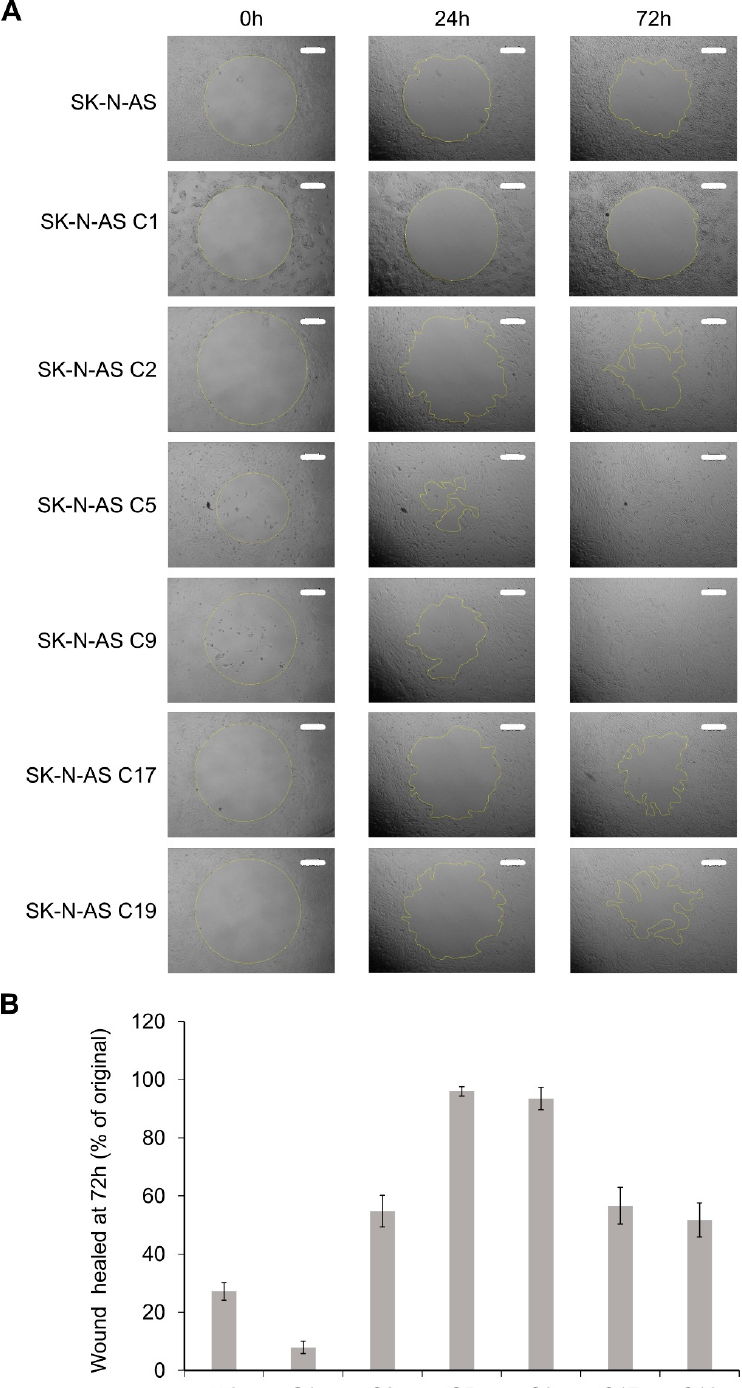
Figure 6. SK-N-AS RET KO cells display enhanced cell migration. ( A ) Phase-contrast microscopy images of indicated RET CRISPR/Cas9 engineered SK-N-AS cells at three time-points (0 h, 24 h, and 72 h) showing the migration difference with radius cell migration assay (scale bar = 300 μ m). Irregular lines indicate the front edge of cell migration, and the cell migrating areas were quantified in ( B ) with ImageJ 1.53a. Values represent the mean ± SD from three independent